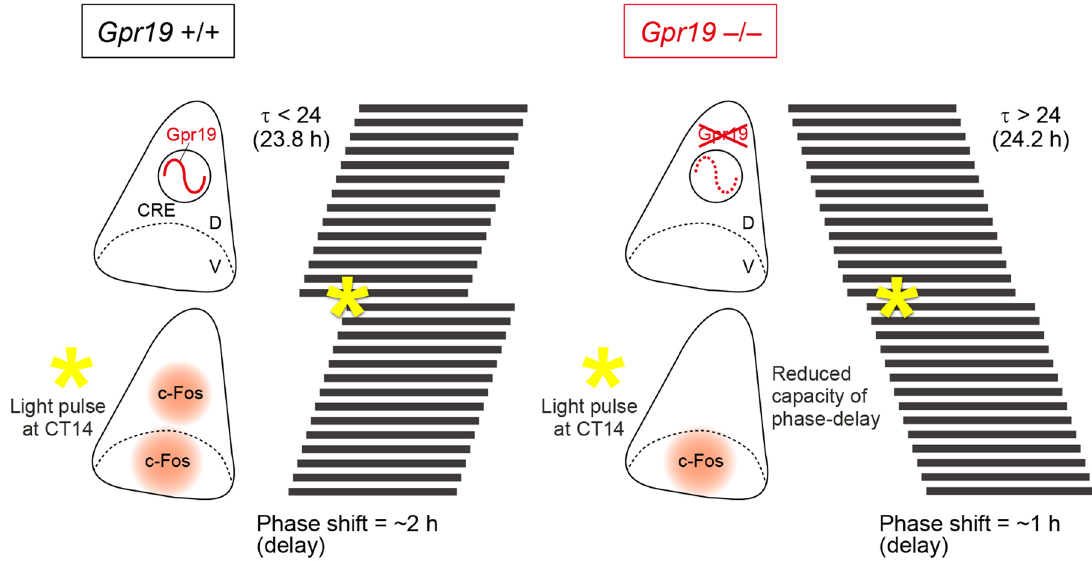
Figure 6. A putative role of Gpr19 in the central circadian clock modulation. The orphan receptor Gpr19 is a circadian oscillating GPCR localised to the middle-dorsal area of the SCN, is involved in the determination of the intrinsic period of locomotor activity rhythm, and modulates the extent of phase shift response to early subjective night light. Gpr19 controls gene expression in the SCN and affects c-Fos expression in the dorsal SCN. Asterisks on the simplified actograms indicate the time of light pulse. τ stands for circadian period length. D, dorsal area; V, ventral area; Orange, c-Fos expression area; CRE, cAMP-responsive